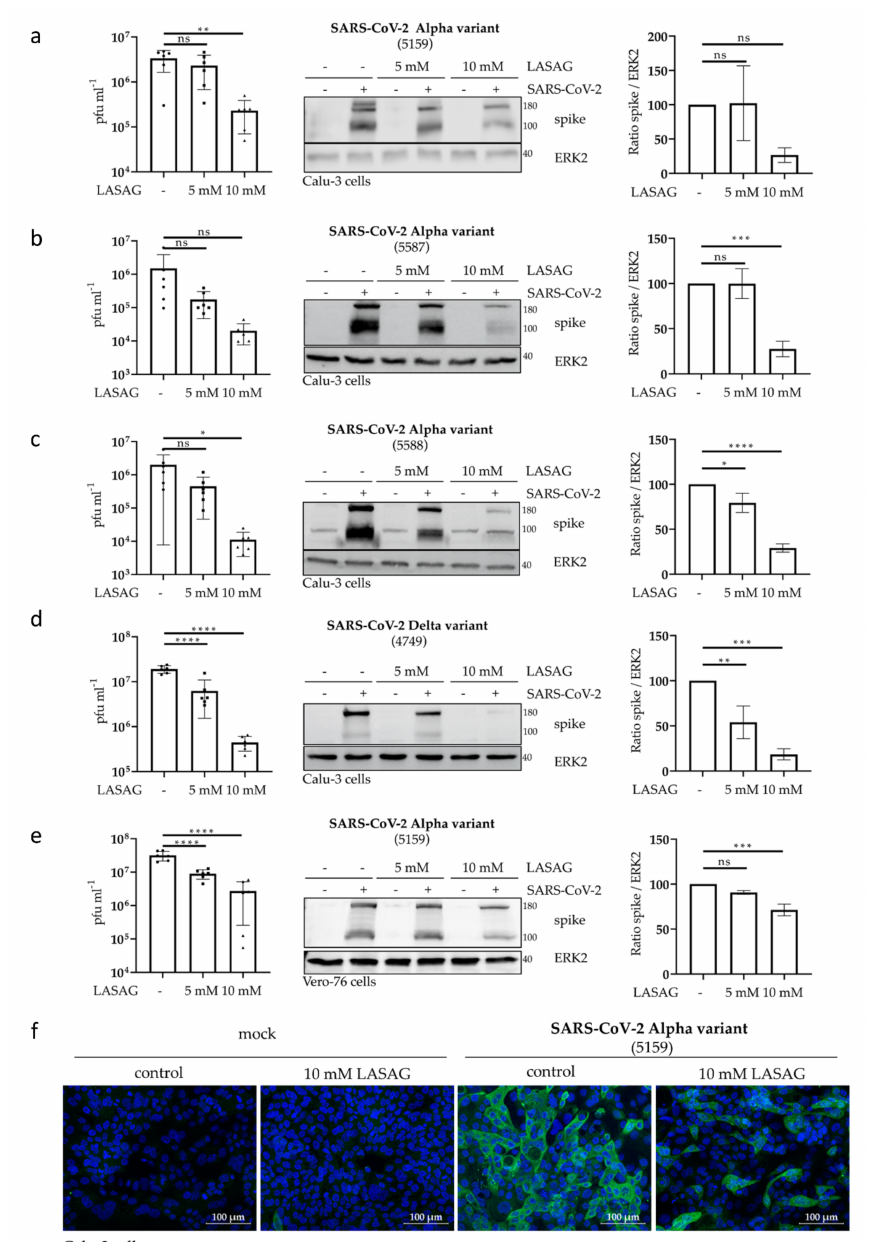
Figure 2. In the presence of LASAG, SARS-CoV-2 replication of different variants is significantly reduced in vitro. Calu-3 ( a – d , f ) and Vero-76 ( e ) cells were left untreated or were incubated with